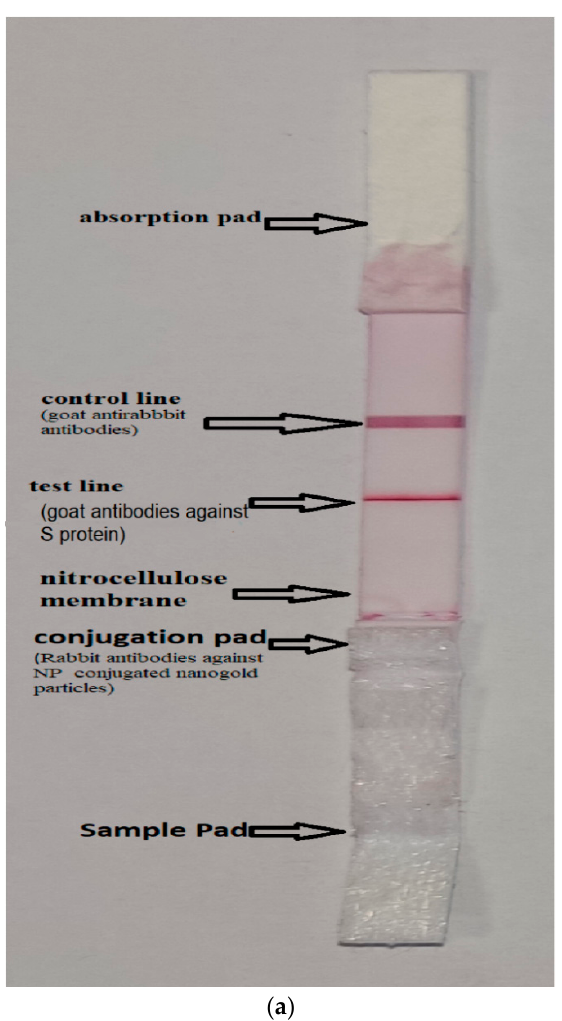
Figure 1. ( a ) The lateral flow assay (LFA) description using the prepared LFA strip showed sample pad, conjugation pad, nitrocellulose membrane, test line, control line and absorption pad; ( b ) lateral flow assay schematic representation of the SARS-CoV-2 virus/antigen visual readout. The virus/antigen is loaded on the sample pad of the LFA strip. The rabbit anti NP antibodies conjugated nanogold particles bind with SARS-CoV-2 virus/antigen and the complex flows down the LFA strip. The test line (T) could be visualized only when SARS-CoV-2 virus/antigen detected by rabbit anti NP antibodies conjugated nanogold particles, whereas the control line (C) should appear for the test validity.